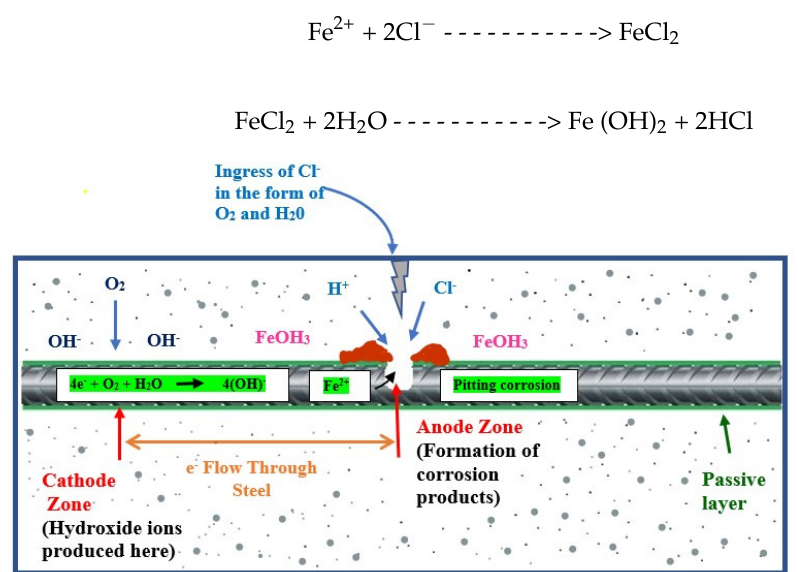
Figure 3. Mechanism of chloride-induced corrosion.